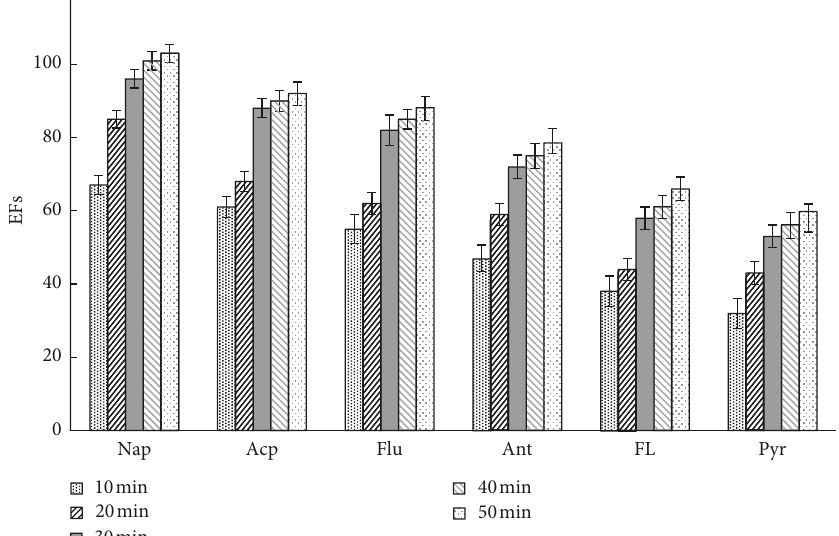
Figure 5: The effect of extraction time on EFs. Other extraction conditions: 10mL of aqueous standards (containing PAHs at a con- centration of 5 μ g · L − 1 ); extraction temperature, 50 ° C; extraction solvent volume, 50 μ L; extraction time, 30min; the concentration of NaCl, 25%. Values are mean of n � 3